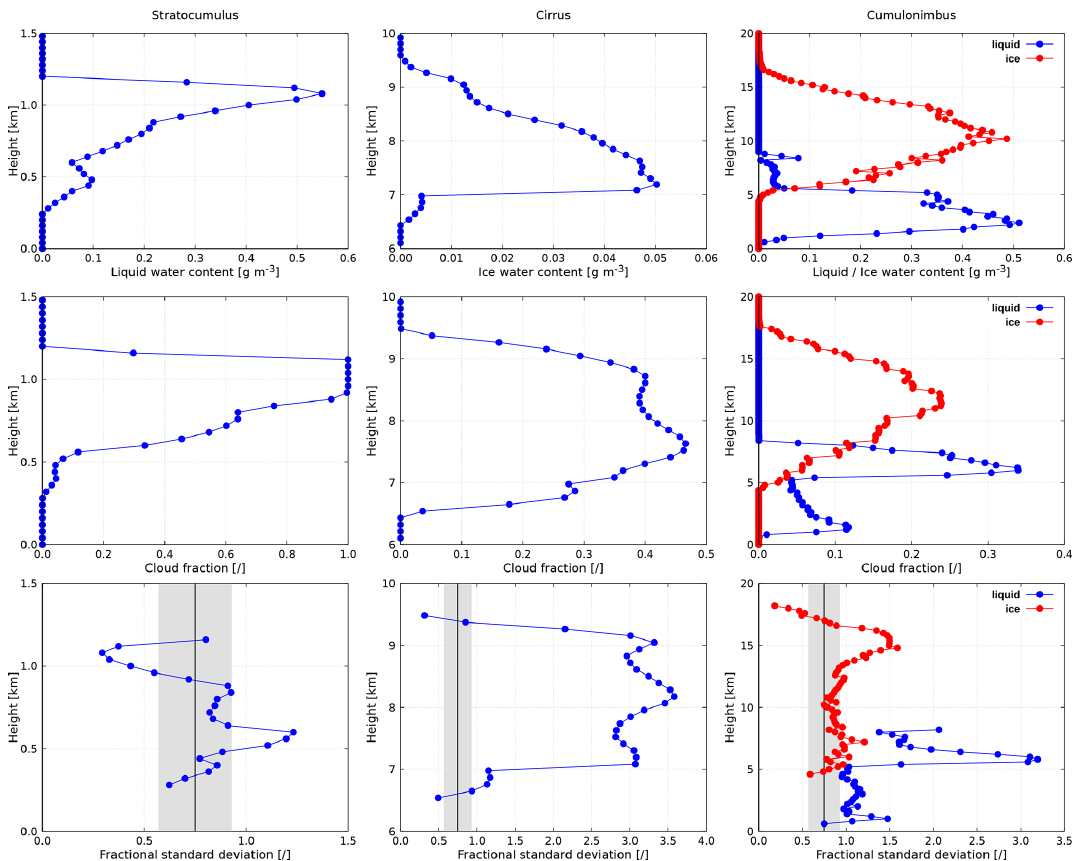
Figure 3. Characterization of selected cloud field case studies in terms of averaged LWC / IWC (top row), cloud fraction (middle row) and fractional standard deviation of LWC / IWC (bottom row), whereby the vertical black line shows the mean global FSD estimate and the gray-shaded area denotes its uncertainty (Shonk et al.,